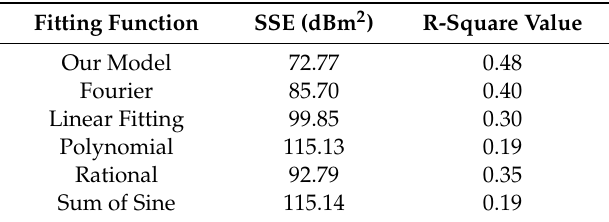
Table 3. Sum of squares due to error (SSE) and coe ffi cient of determination (R-square) values of the di ff erent fitting